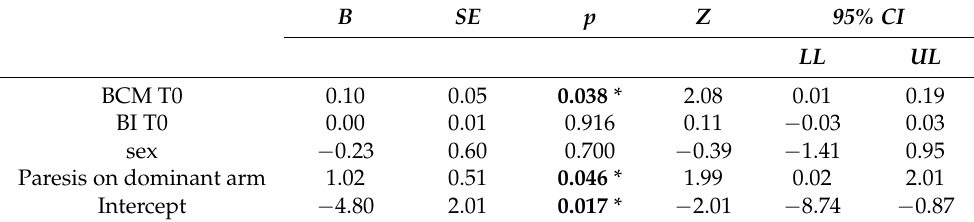
Table 5. Multiple logistic regression analysis for recovery in